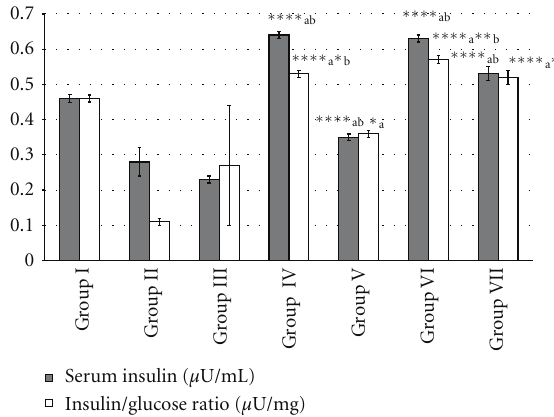
Figure 3: E ff ect of MREt on hepatic glycogen and total lipids (g/g). Each bar represents the mean ± SEM ( n = 6) . ∗ P < 0 . 05 and ∗∗∗∗ P < 0 . 0001, when compared with group II (a) and (b) III.